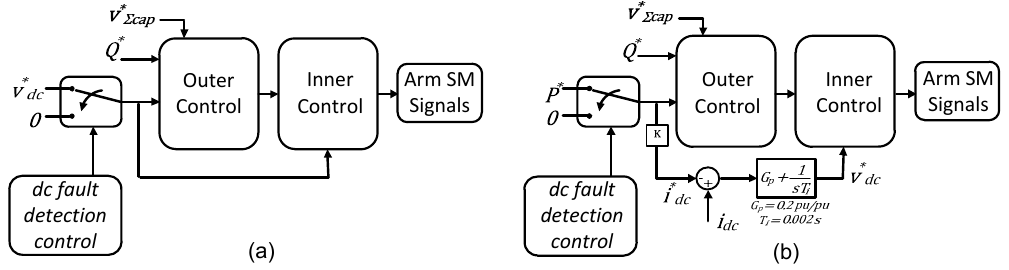
Figure 11. Overall FBMMC control considering the DC fault detection control: ( a ) DC voltage FBMMC